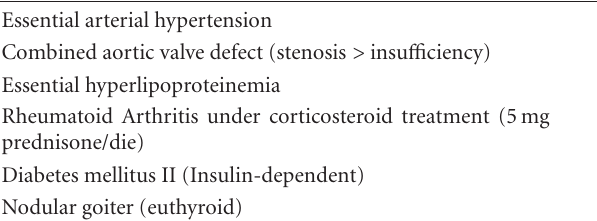
Table 1: Anamnesis. Table 2: The patient’s concomitant